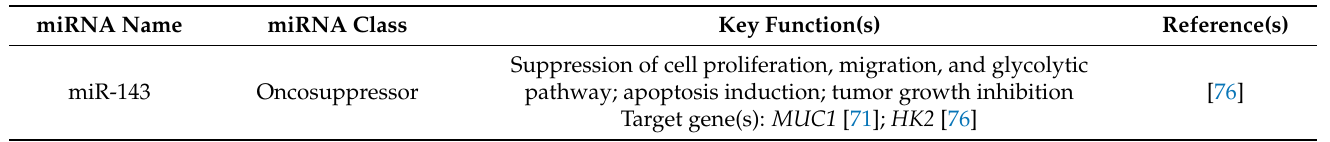
Table 3. Select miRNA molecules and siRNA/shRNA molecular targets described in current preclinical studies on TNBC